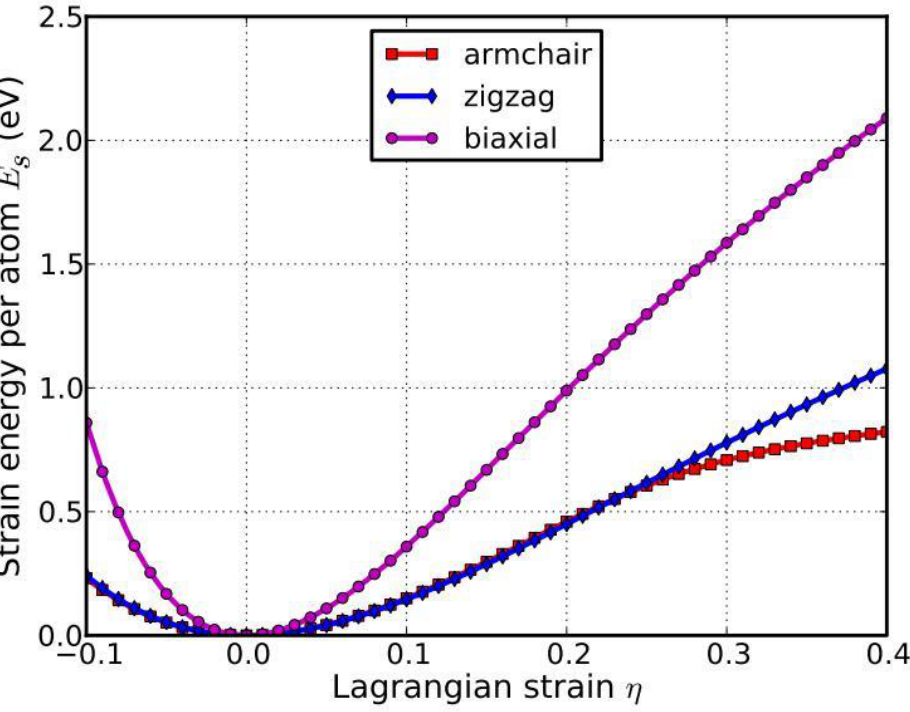
Figure 14. Energy–strain responses for uniaxial strain in armchair and zigzag directions, and equibiaxial strains.